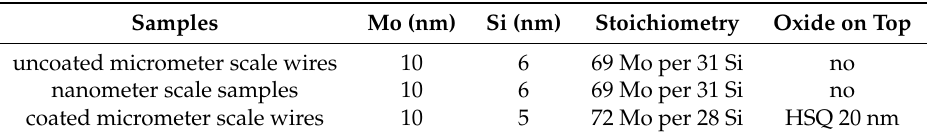
Table A1. Amount of molybdenium and silicon before annealing, average number of molybdenium atoms per silicon atoms in the compound, and presence or absence of protective oxide above MoSi when exposed to FIB. The proportion of molybdenum atoms to silicon atoms is calculated from the material thickness values using textbook values for density and molar mass. The thickness values are obtained from calibrated sputtering